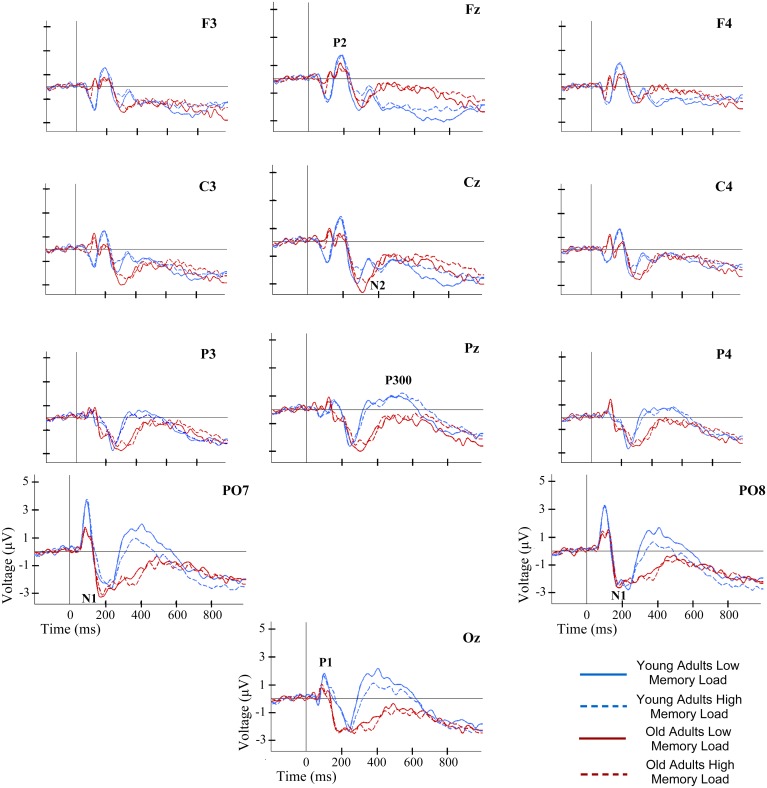
ERP waveforms at several electrode locations during recognition of information in WM.ERP waveforms for each group and memory load condition.